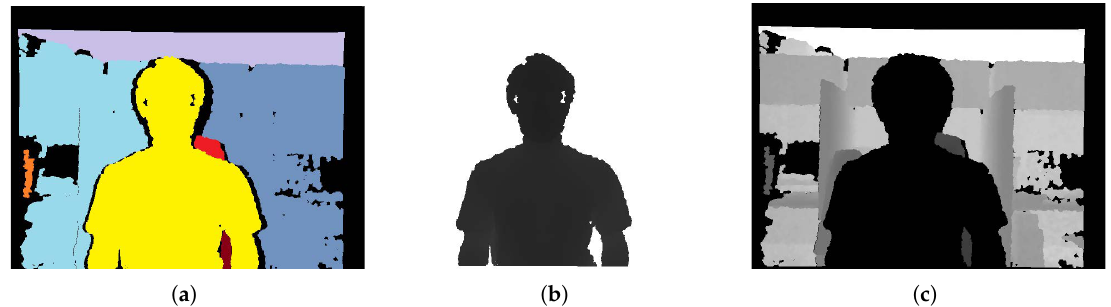
Figure 7. ( a ) Labeled depth image (colored markers correspond to connected component labeling results in Figure 6a); Extracted ( b ) object and ( c ) background regions of the depth image in x - y